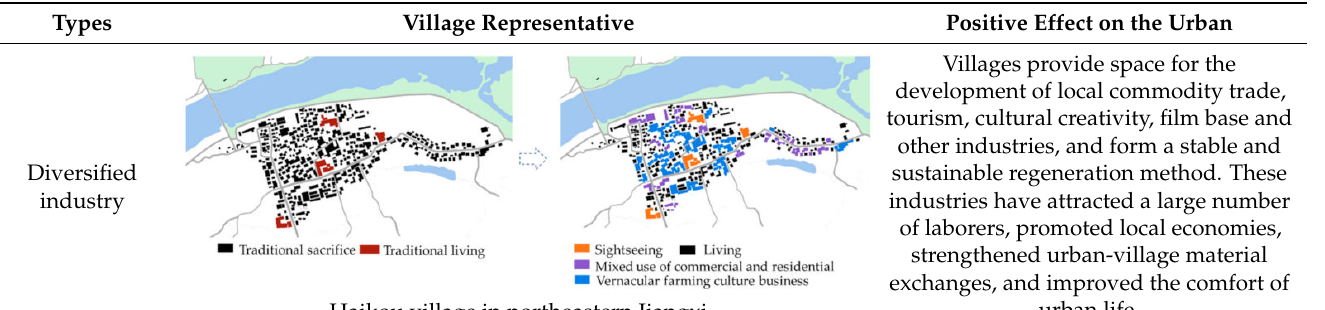
Table 8. Urban regeneration types of traditional villages in Jiangnan region: edited by authors, information is obtained from field research, photograph taken by